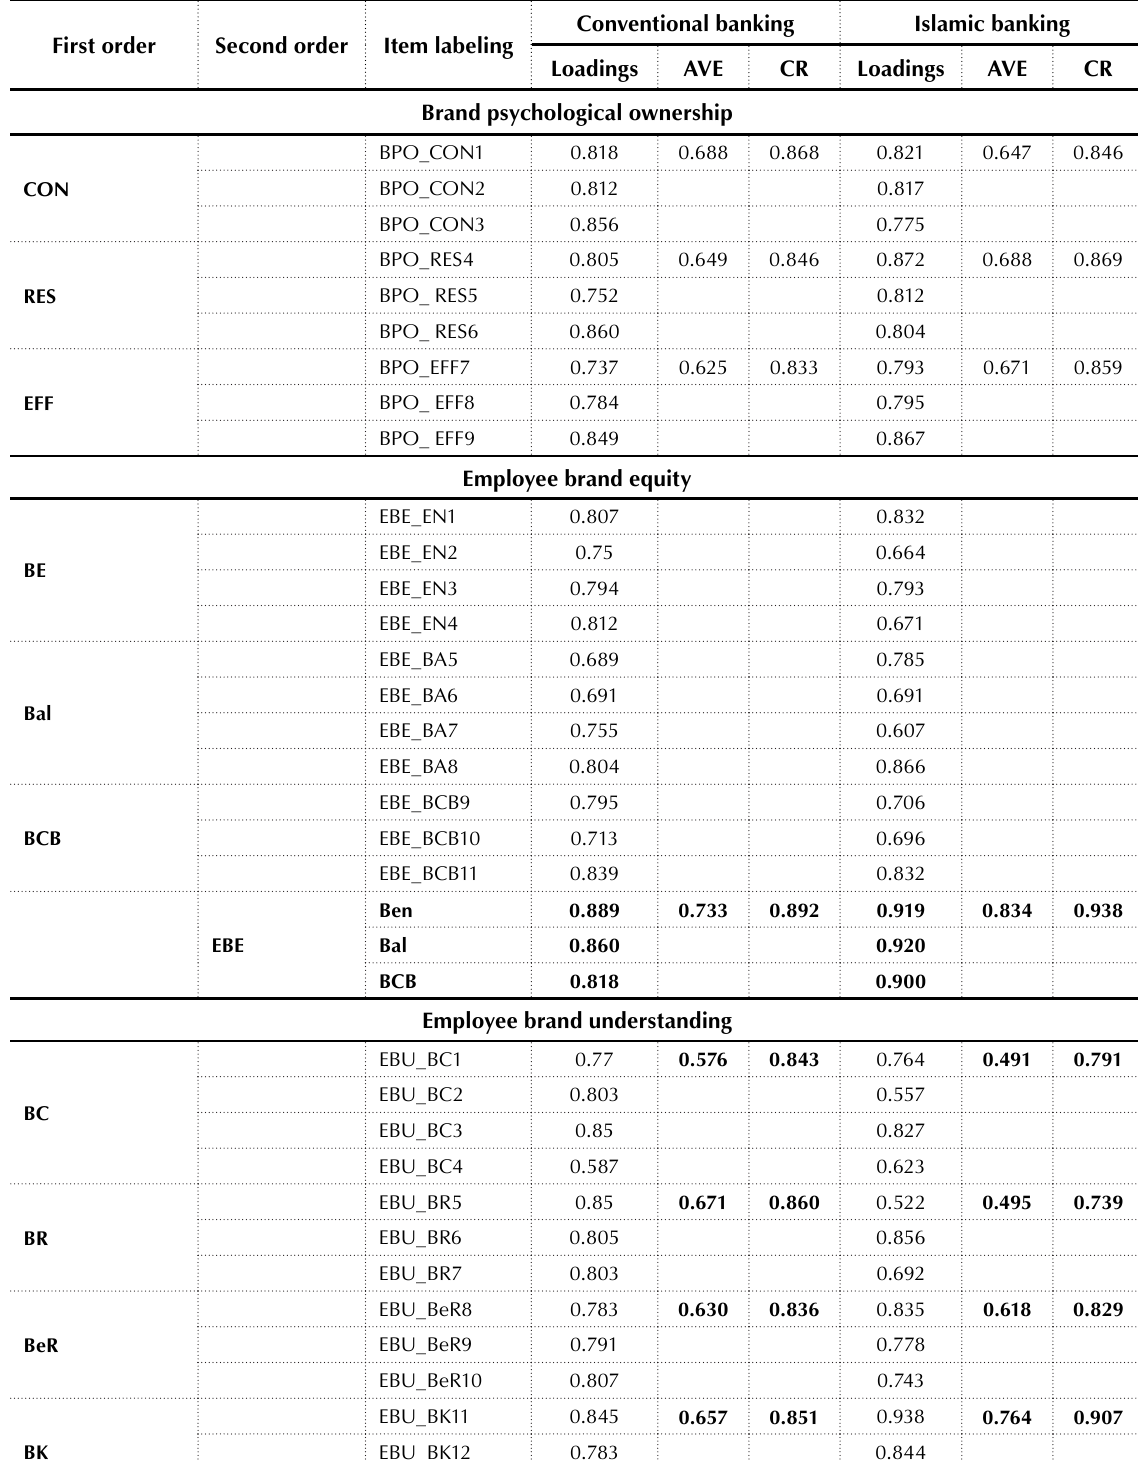
Table 1. Instrument, standardized loadings, AVE, CR and Cronbach’s